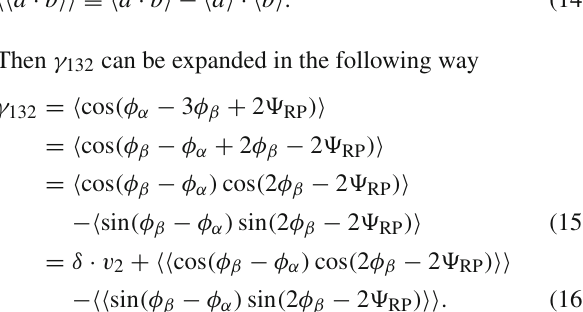
Fig. 5 Centrality dependence of κ 112 (upper), κ 132 (middle) and κ 123 √ s NN = 200 GeV. (lower) from AMPT in Au+Au collisions at κ 123 results from the 3-particles method are not shown to avoid clutter. The STAR data of κ 112 and a background estimate using PHOBOS v 2 results are also shown in panel (a) in comparison v · δ SS ( OS ) from STAR. The cancellation of the two cumulant 2 terms also makes γ 132 a nearly-pure-background